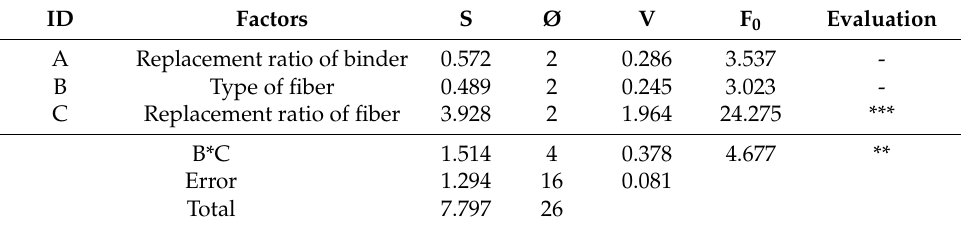
Table 10. Variance analysis for absorption ratio of the extrusion panel.